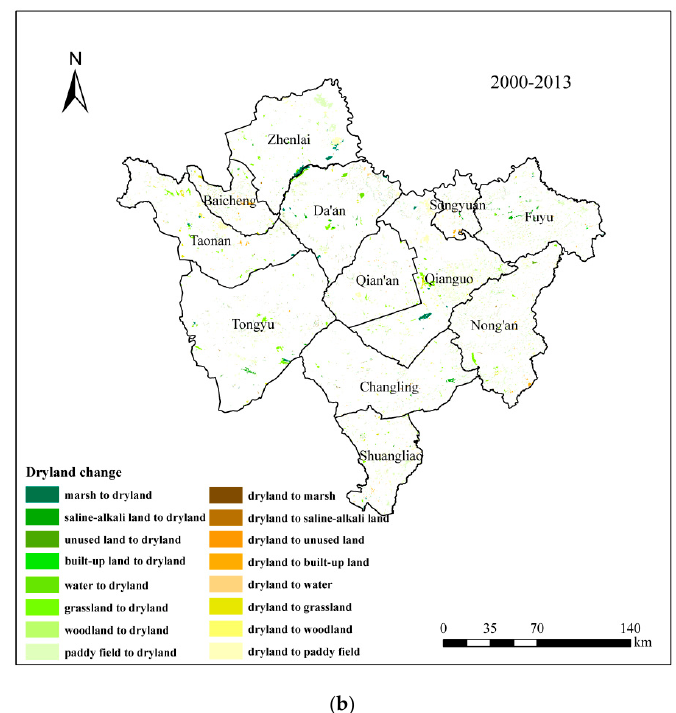
Figure 6. Farmland change between 1975 and 2000, and between 2000 and 2013 ( a ) between 1975 and 2000; ( b ) between 2000 and 2013. The areas with a decreasing and increasing dryland were all sporadically located in the whole area of Western Jilin. The increasing dryland mainly came from grassland (261.35 km 2 ), paddy field (157.49 km 2 ), woodland (127.09 km 2 ) and built-up land (124.35 km 2 ). Table 1. The area of farmland change between 1975 and 2000, and between 2000 and 2013 (km 2 ).